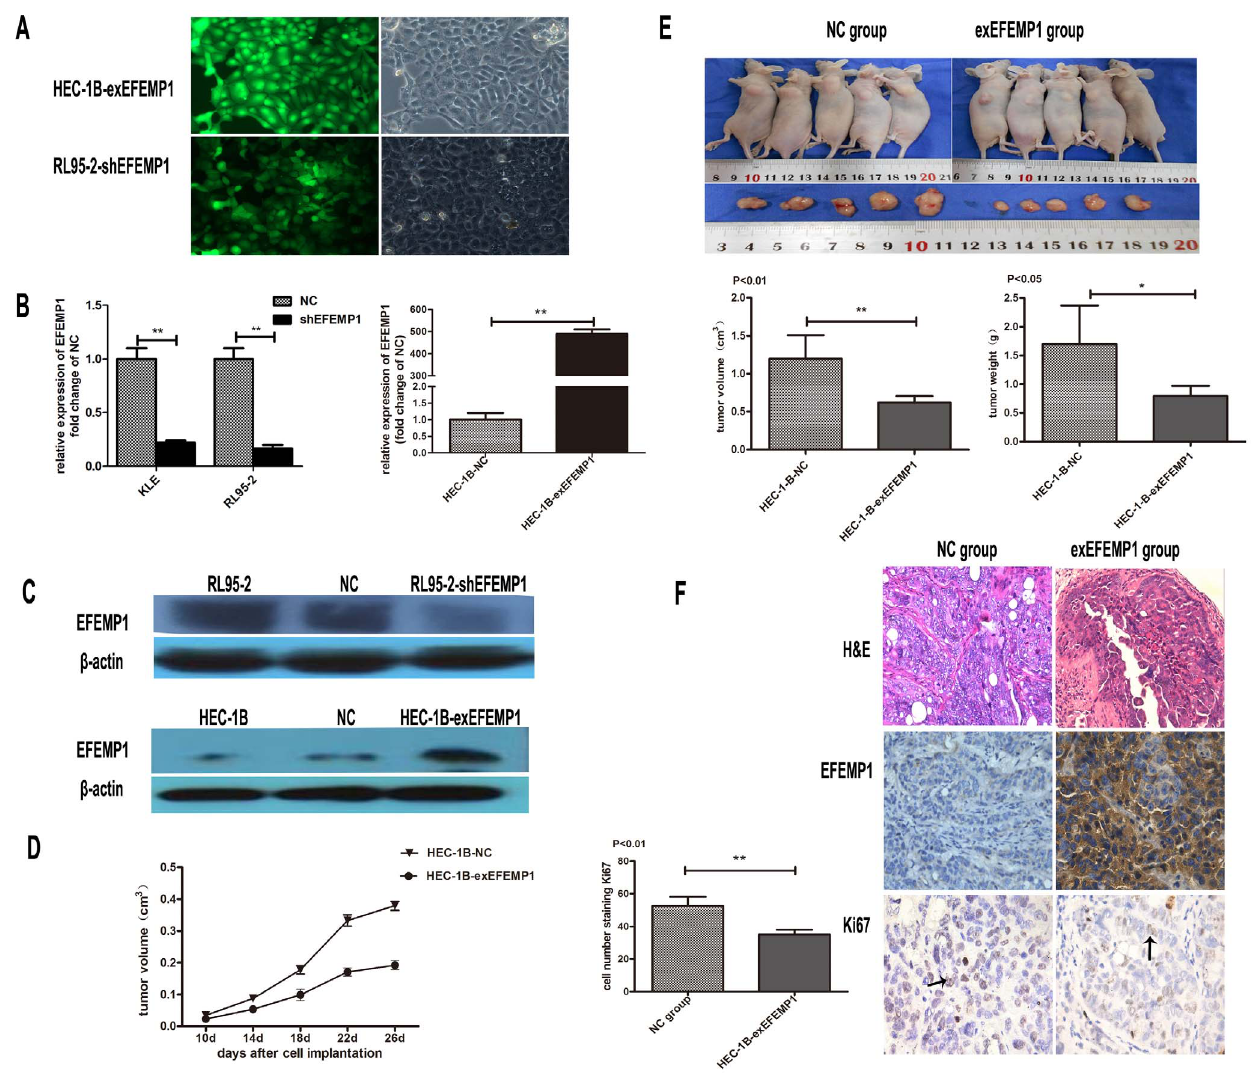
Figure 4. The effect of EFEMP1 on tumor growth invivo . A: Stable transfection of HEC-1B cells and RL95-2 cells with pCMV6/GFP/Neo-EFEMP1 and shEFEMP1. The percentage of transfected cells with fluorescence was . 95%. B: Levels of mRNA expression of EFEMP1 as evaluated by qRT-PCR after transfecting cells with these plasmids. The experiments here were repeated twice, and each was done in triplicate, ** P , 0.01. C: Western immunoblot to demonstrate the efficacy of these plasmids. D: Showing the comparative growth rate of tumors formed from HEC-1B-NC and HEC-1B- exEFEMP1. Ten days after injection the size of the tumor was measured every 4 days. P , 0.05. E: Four wks after injection of HEC-1B-NC and HEC-1B- exEFEMP1, the weight and volume of the tumors were measured. Arithmetic means (bars) and SD (error bars) are shown, * P , 0.05, **P , 0.01. F: Nude mice tumor tissues were paraffin embedded and tumor slides were stained with hematoxylin and eosin (magnification was 6 400), antibody of EFEMP1 ( 6 400) and Ki67 ( 6 400). The black arrow indicates positively-stained cells for Ki67, at least five regions were randomly selected to score positive cells (mean 6 SD, P , 0.01).